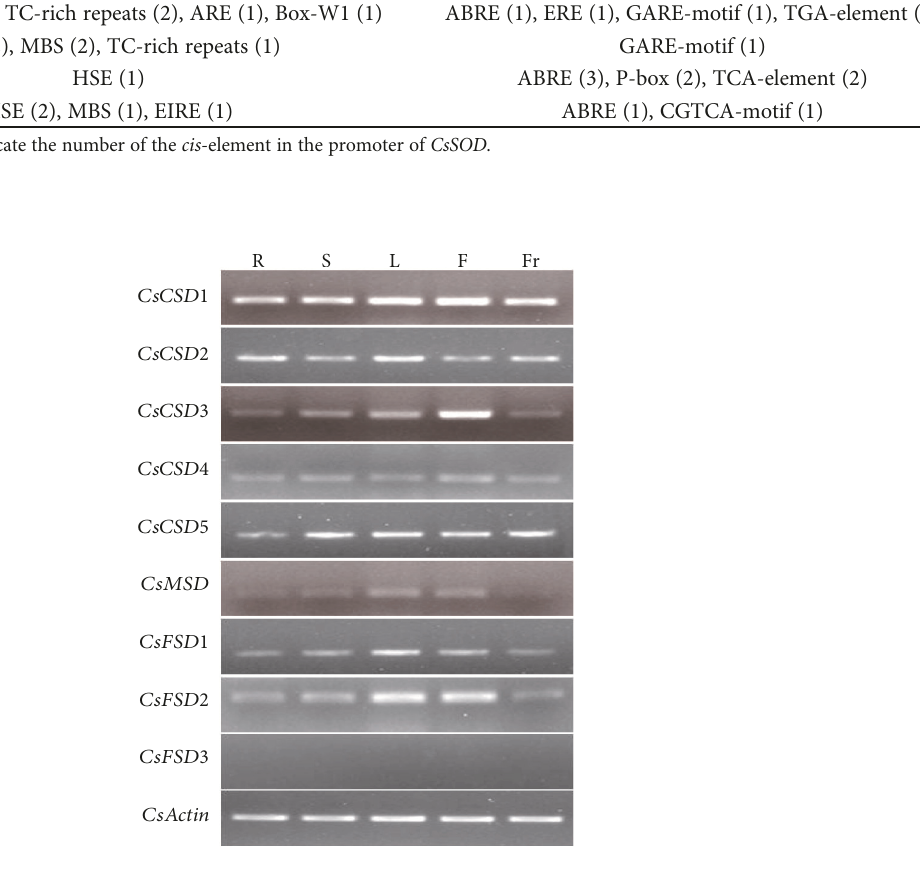
Figure 6: RT-PCR analysis of cucumber SOD genes in di ff erent tissues. RNA was isolated from di ff erent tissues, including root (R), stem (S), leaf (L), fl ower (F), and fruit